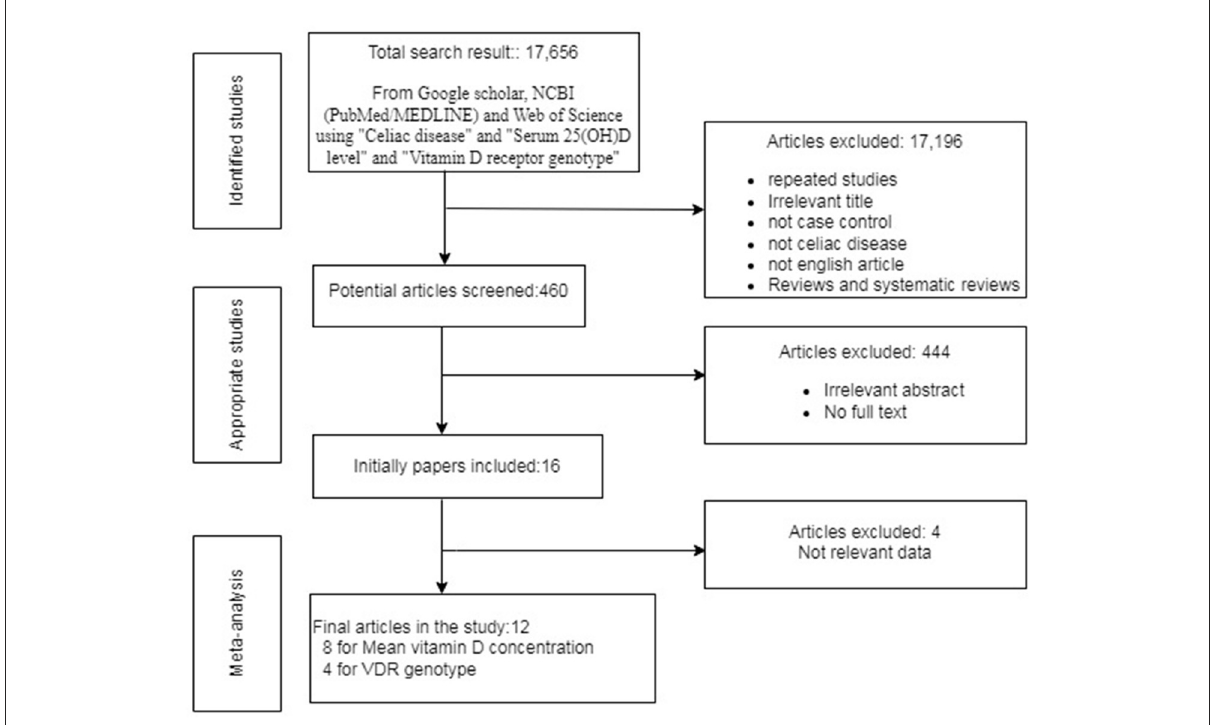
FIGURE1 Flow chart exhibiting the inclusion of eligible studies for